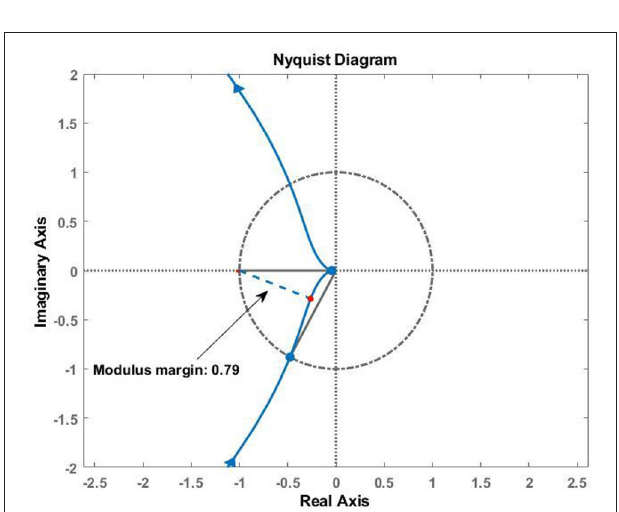
FIGURE 8 | Frequency characteristics of the transfer functions from the ) and after ( G FF ) including the reference F ref and from the angular velocity ω a to the control signal T mp . mp ref ) and after ( G B F ω ) a a